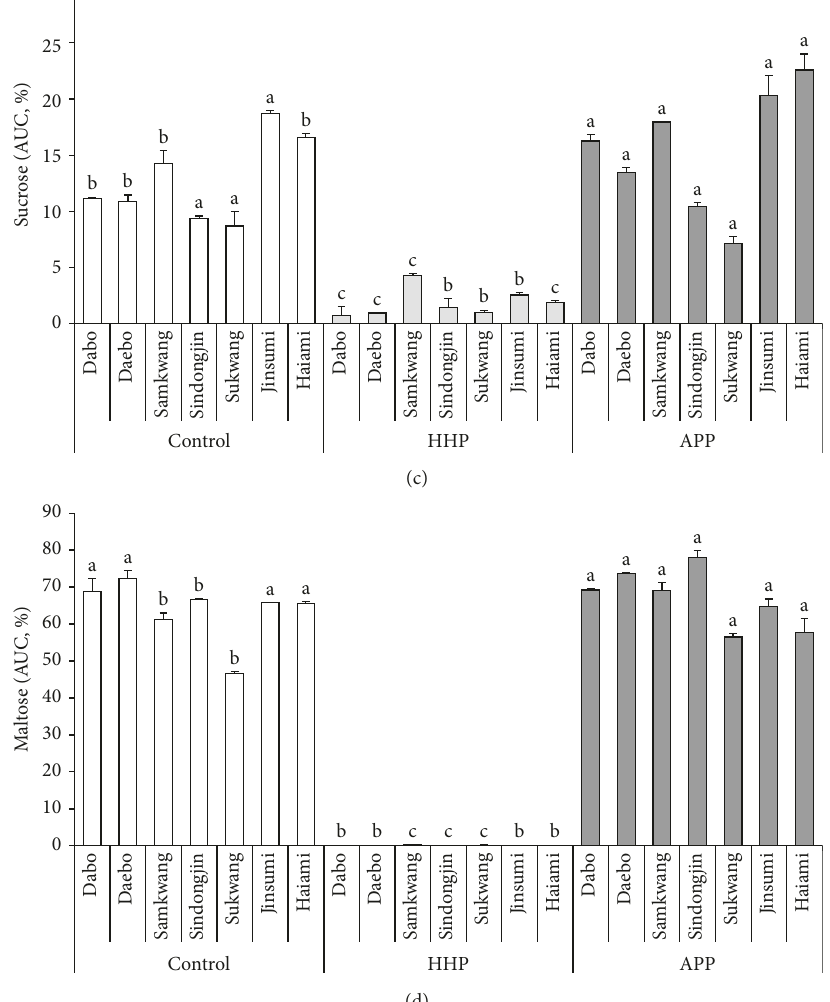
Figure 3: Sugar (fructose, glucose, sucrose, and maltose) contents of rice. Samples were treated by high hydrostatic pressure or atmospheric pressure plasma, and sugar contents were compared to control. Values with different superscripts are significantly different at p according to Tukey’s multiple range tests within the same cultivar. AUC, area under the